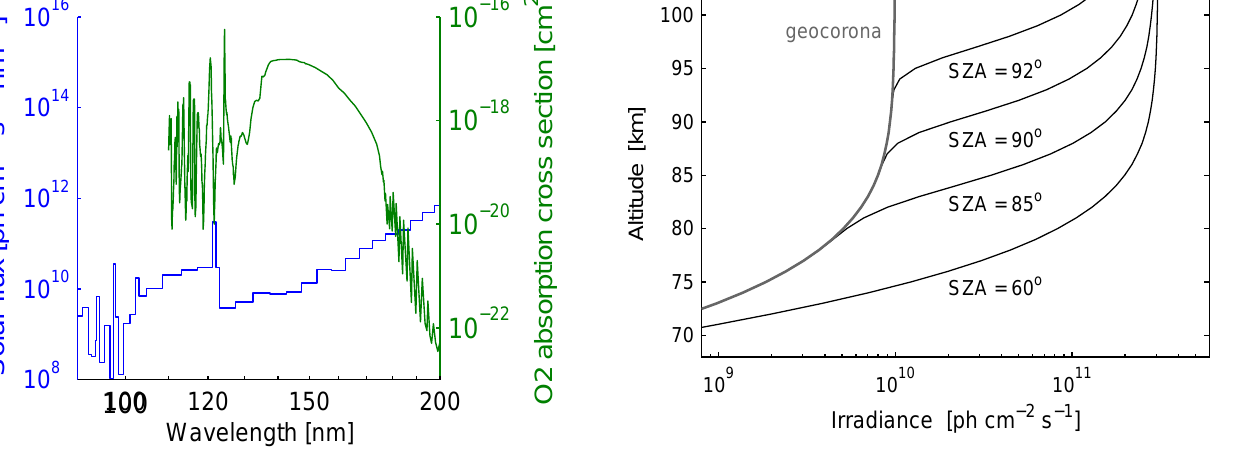
Fig. 1. Solar spectrum and O 2 absorption cross section around the Lyman- α line at 121.57nm.